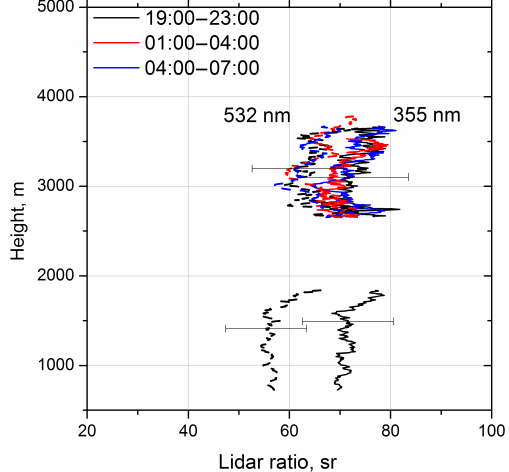
Figure 10. Particle depolarization ratio as a function of the extinc- tion Ångström exponent derived from data shown in Figs. 7 and